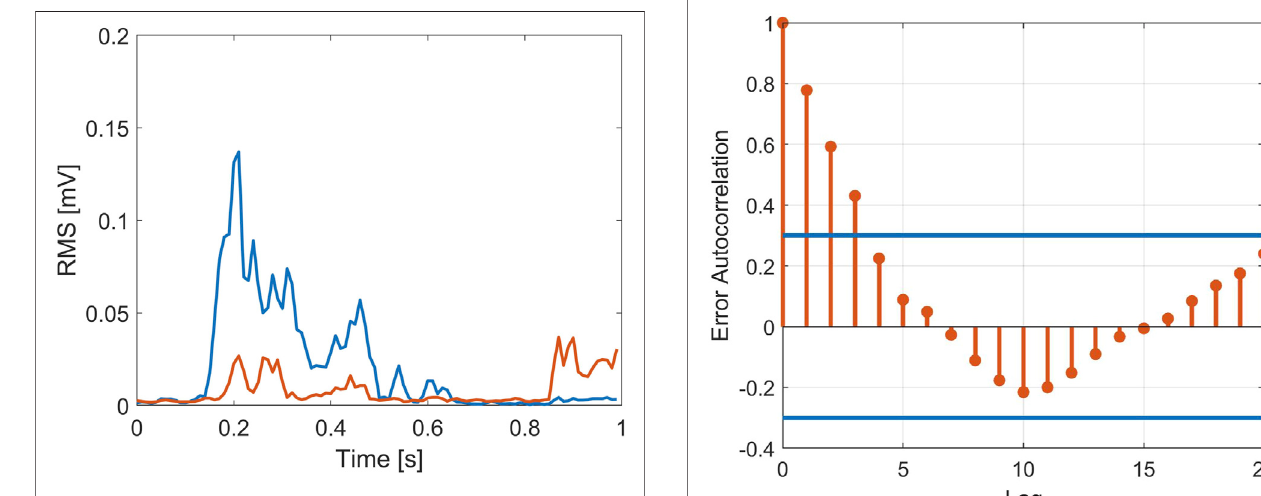
FIGURE4| Rootmeansquare(RMS)valueofthemyoelectricactivity for the tibialis anterior (red line) and gastrocnemius (blue line) recorded during the EO trial, from a representative subject.